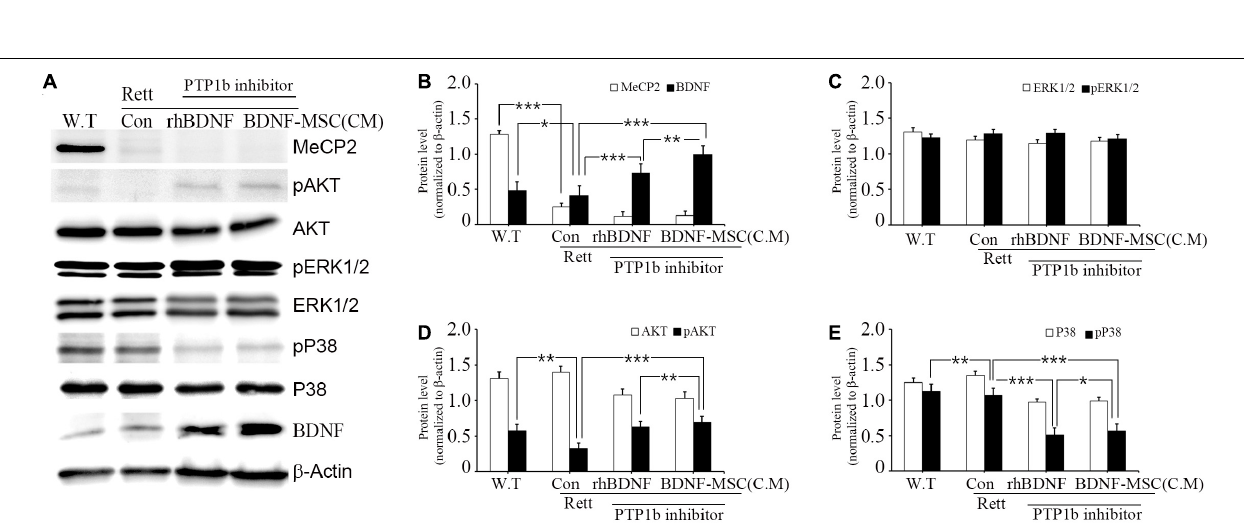
Frontiers in Neuroscience |